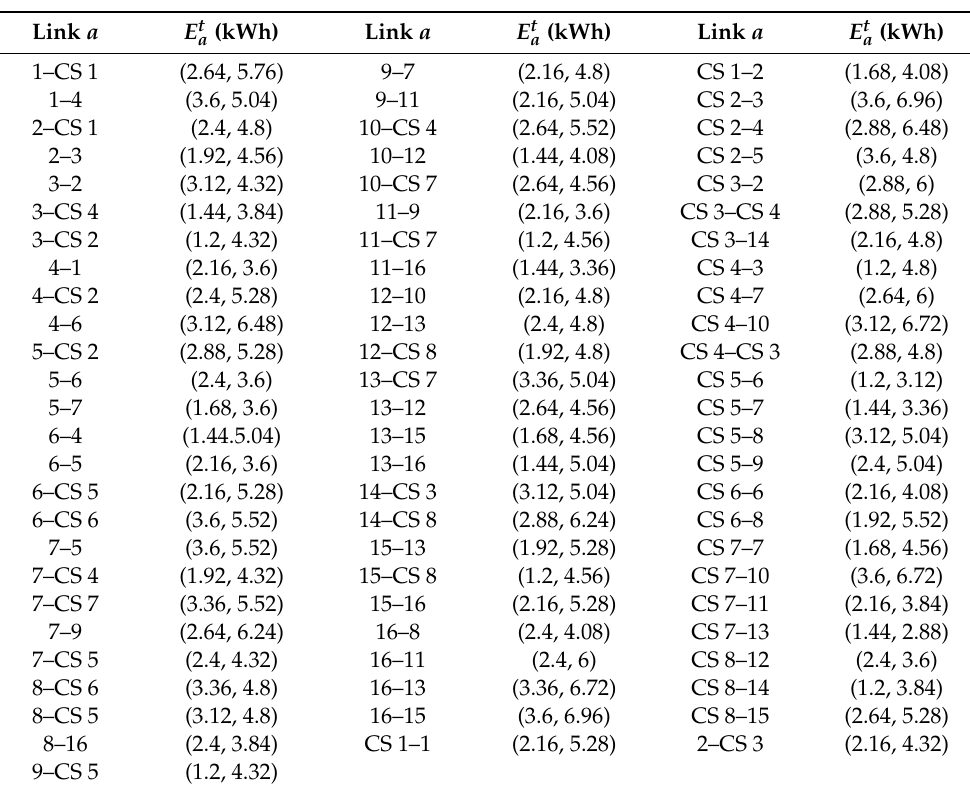
Table A3. Value intervals of energy consumption E t a for link a at time slot t